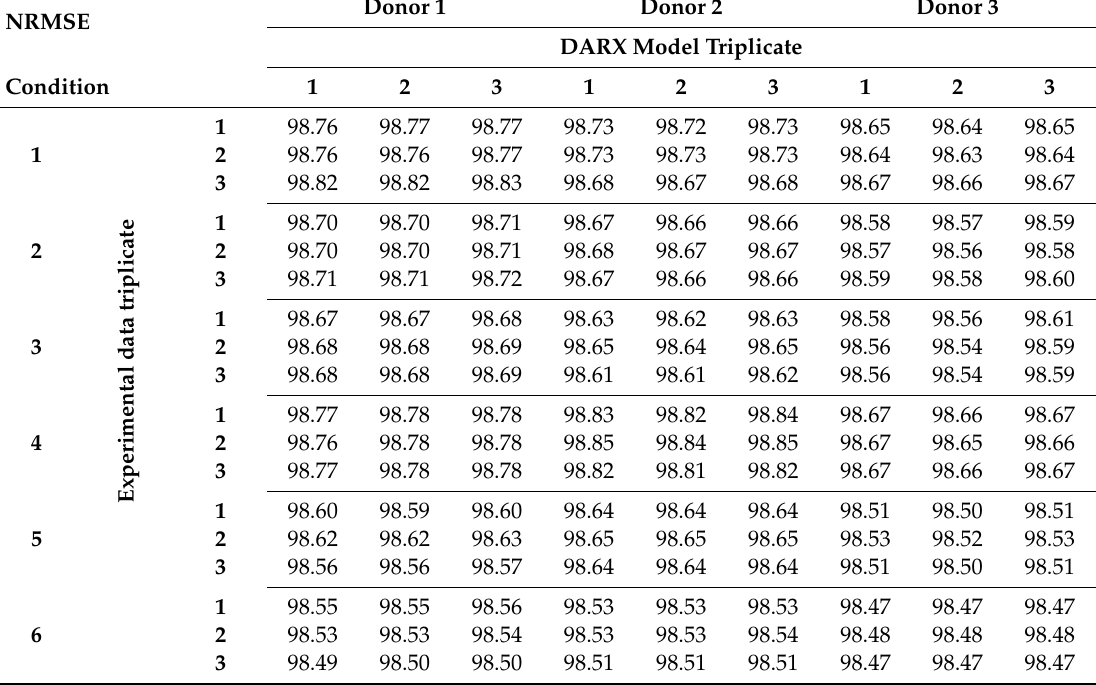
Table 7. The accuracy of the MPC simulation is measured using NRMSE and multiplied by 100 to be expressed as a percentage, with 100 being a perfect fit. The accuracy of the MPC simulation is represented as the di ff erence between output (accumulated lactate (mM)) of the experimental data compared to the output of the simulated data. The DARX model used to perform the simulation is either the one based on the corresponding experimental data (diagonal values) or on the data of an experimental